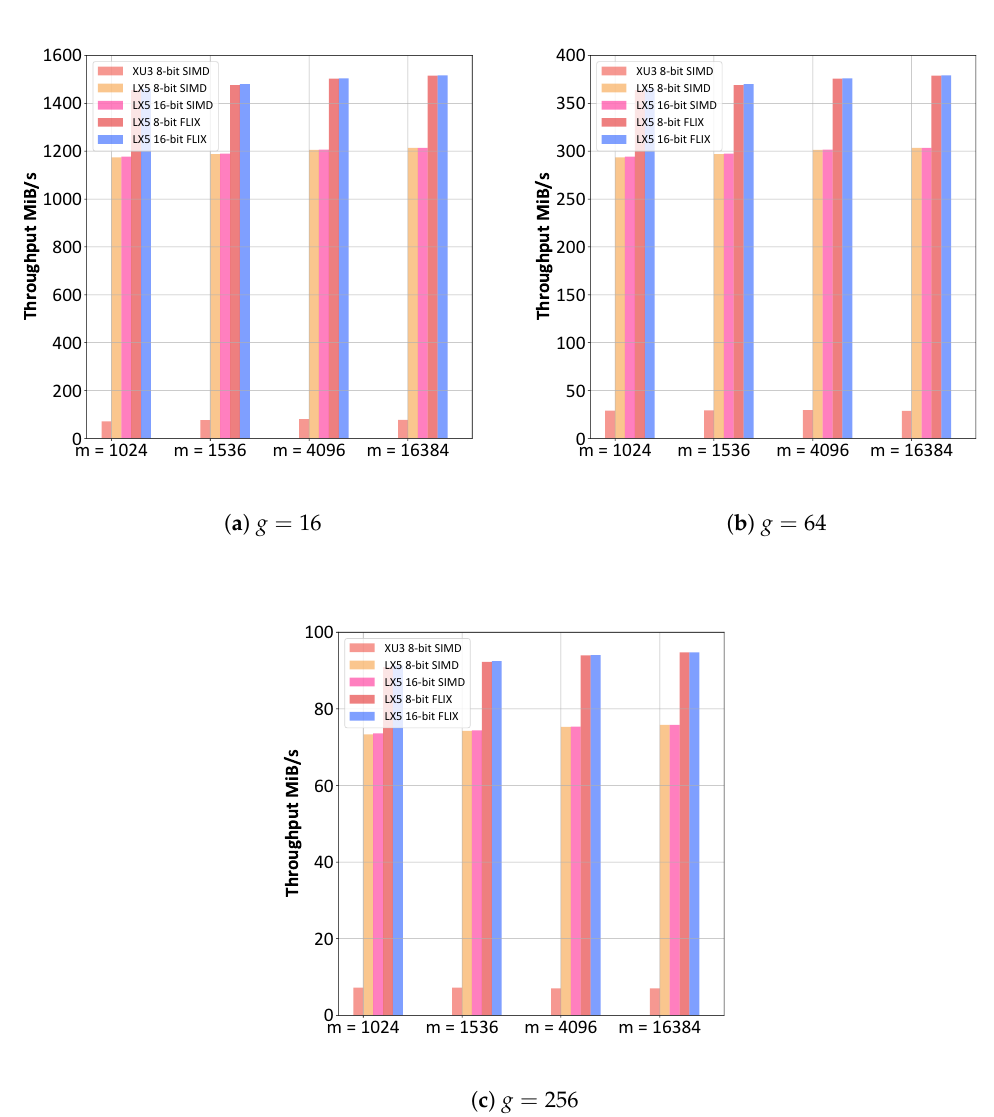
Figure 7. RLNC encoding throughput (in MiB/s = 2 20 Byte/s) comparison between ODROID XU3 with SIMD (NEON) instructions and Xtensa LX5 core with SIMD and FLIX TIE instructions for various generation sizes ( g ) and symbol (packet) sizes ( m